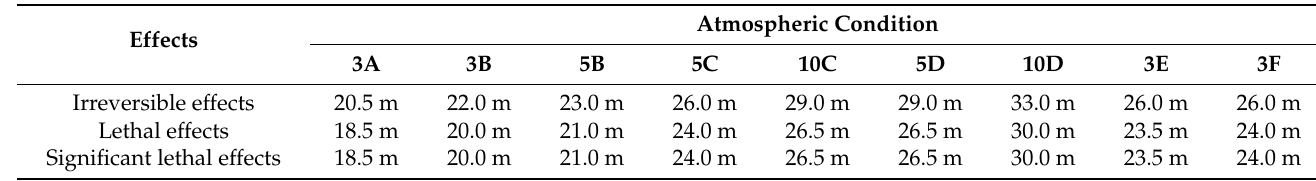
Table 8. Maximum distances of effects for a flash fire in the scenario EZ53 salt